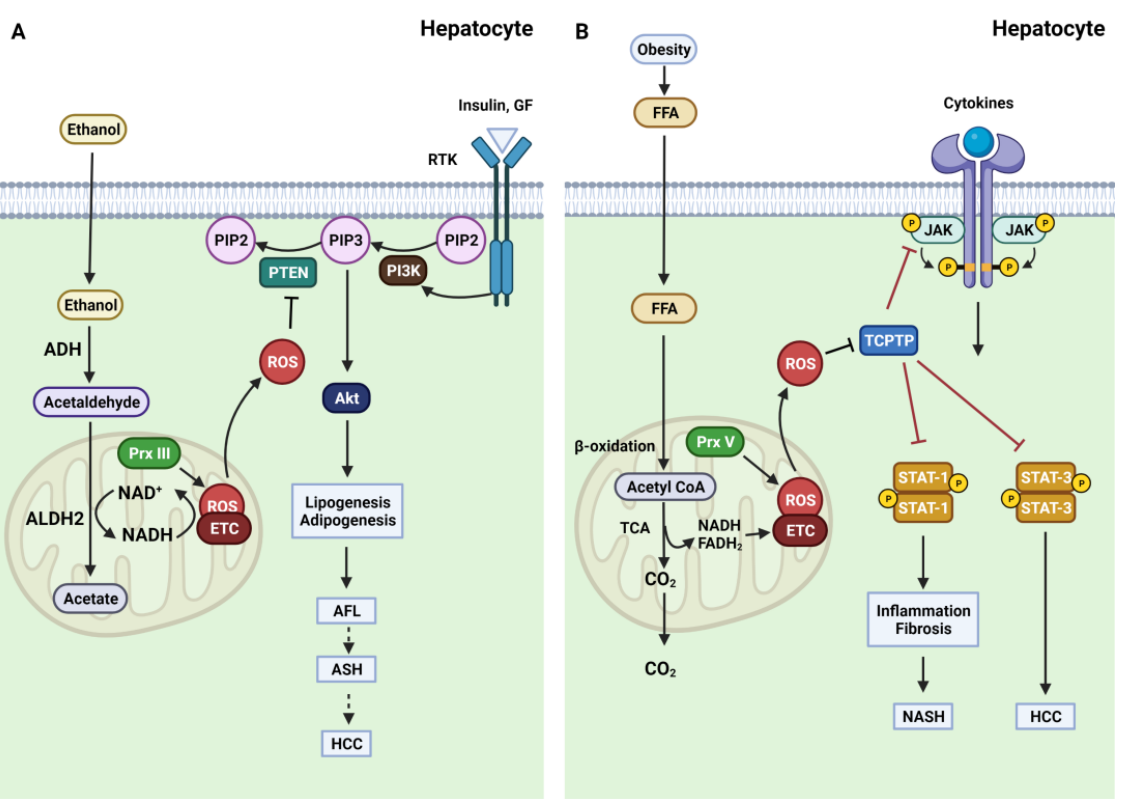
Figure 2. Oxidative inactivation of PTEN in ALD and TCPTP in NAFLD. ( A ). Ethanol is transported into the cytosol of hepatocytes, where ethanol metabolism occurs. Ethanol oxidation into acetaldehyde is primarily responsible for ADH, and this intermediate acetaldehyde product is converted to acetate by ALDH2 in the mitochondria. This conversion generates ROS via ETC-induced mitochondrial dysfunction. ROS overproduction causes oxidative inactivation of PTEN, leading to Akt hyperactivation and, finally, hepatic steatosis. ( B ). FFA arising from HFD-induced obesity is transported to the cytosol. Most FFA is metabolized by β -oxidation in the mitochondria. Increased FFA levels are associated with overloaded β -oxidation and subsequent mitochondrial dysfunction. ROS are overproduced due to elevated electron transfer from NADH and FADH 2 to the ETC. Enhanced ROS levels induce TCPTP oxidation, activating JAK, STAT-1, and STAT-3 signaling. The hyperactivation of STAT-1 accelerates the development of NASH, while the hyperactivation of STAT-3 triggers HCC.